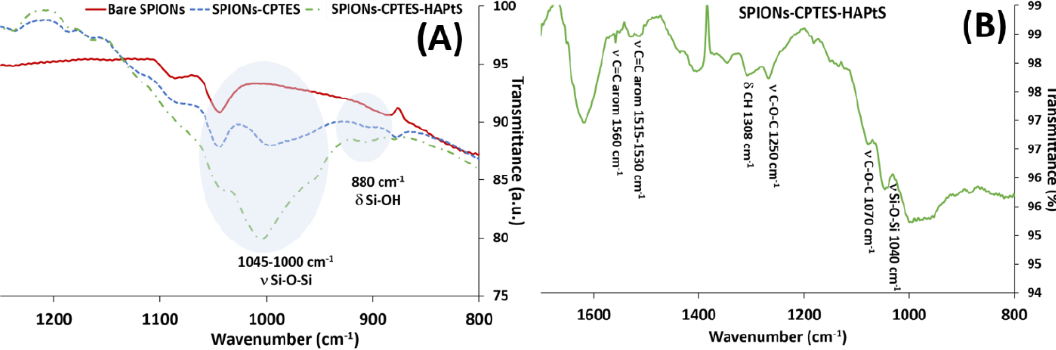
Figure 7. Infrared spectra of ( A ) bare SPIONs, SPIONs-CPTES, and SPIONs-CPTES-HAPtS (spectra range from 1250 to 800 cm −1 ), and ( B ) SPIONs-CPTES-HAPtS (from 1700 to 800 cm −1 ).